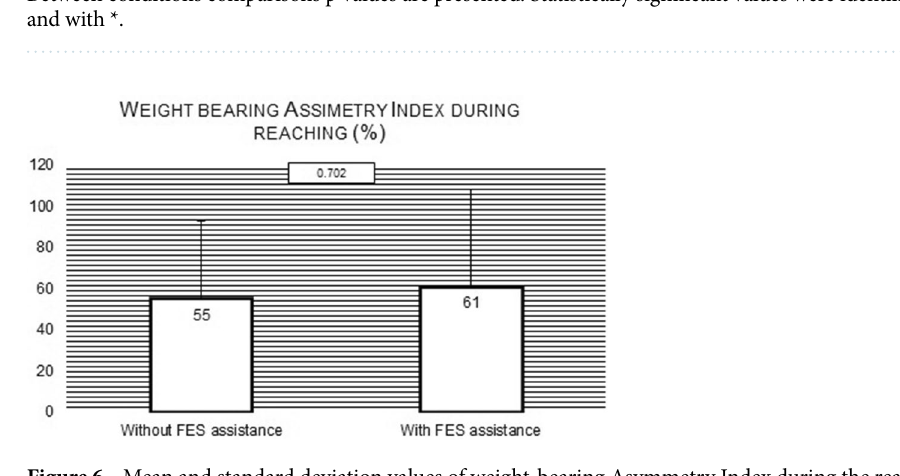
Figure 5. Mean and standard deviation values of displacement of CoP, CoM, and CoP-CoM for AP, ML, and AP-ML directions during the reaching phase of turning on the light with and without FES-HAND assistance. Between conditions comparisons p values are presented. Statistically significant values were identified in bold and with *.